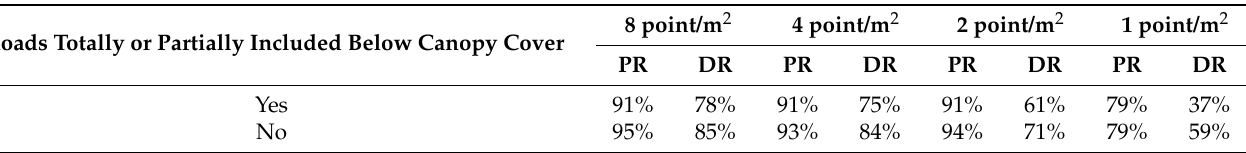
Table 3. Completeness in relation to the roads occluded by canopy cover (area of influence = 3 m, value proposed by Doucette et al.